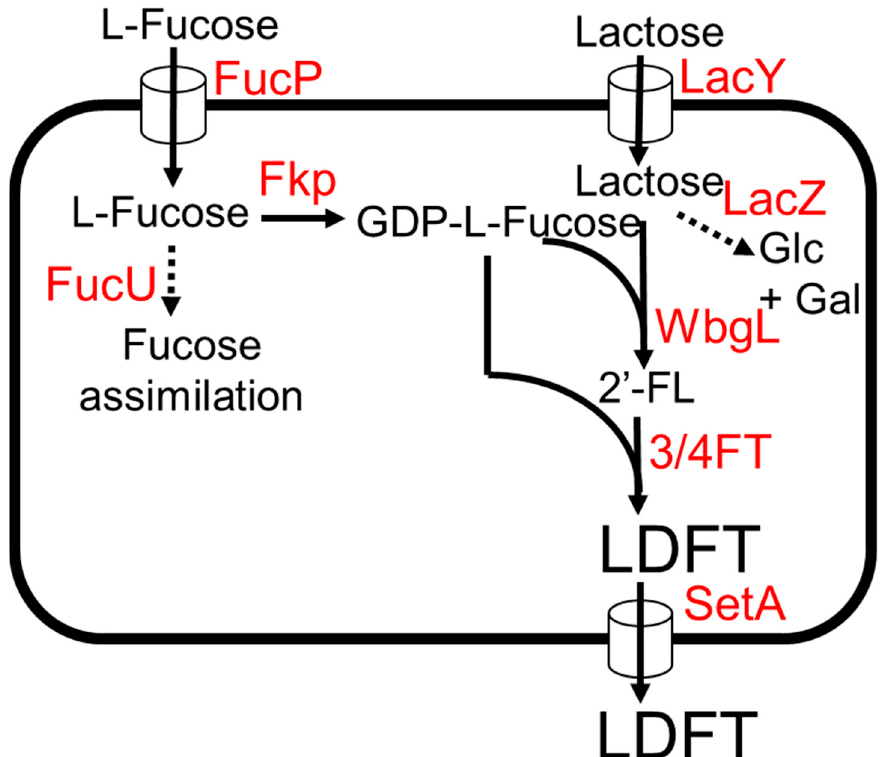
Figure 4. The LDFT production from L-fucose and lactose . Dotted arrows indicate